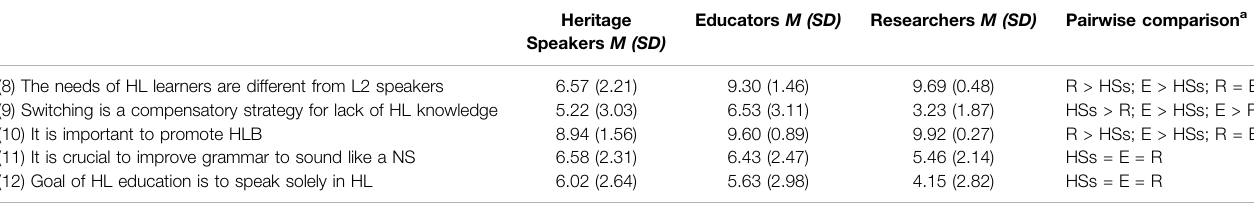
Heritage Educators M (SD) Researchers M (SD) Pairwise comparison a Speakers M (SD)